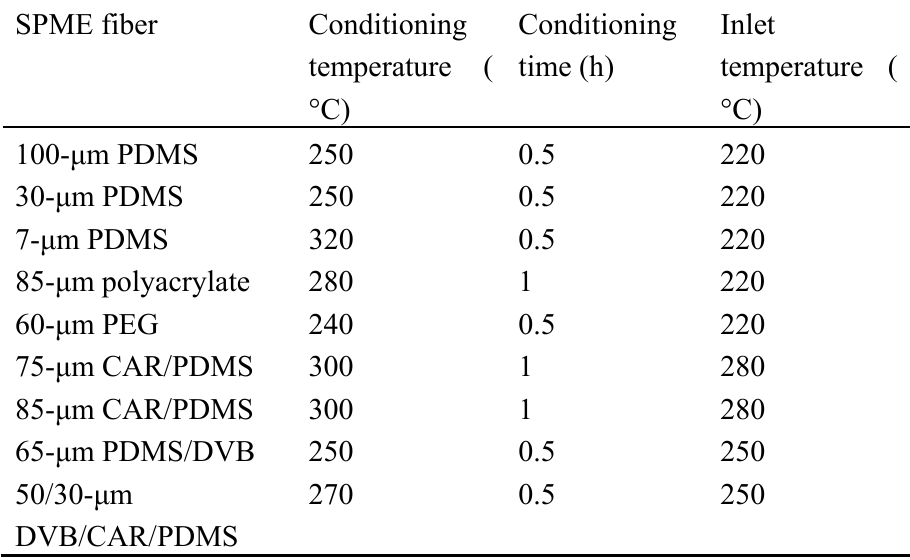
Table 3. Conditioning temperature and time for the SPME fibers used in the